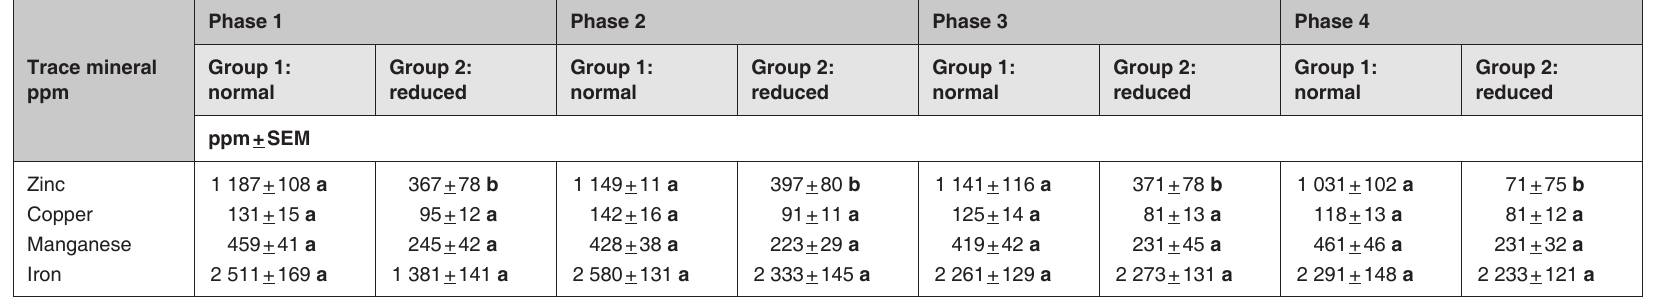
TABLE 3 Analysed trace mineral composition of the faeces (dry matter basis) of the pigs. Group 1 received trace mineral levels suggested by the NRC, USA (1998), while Group 2 re­ ceived reduced levels